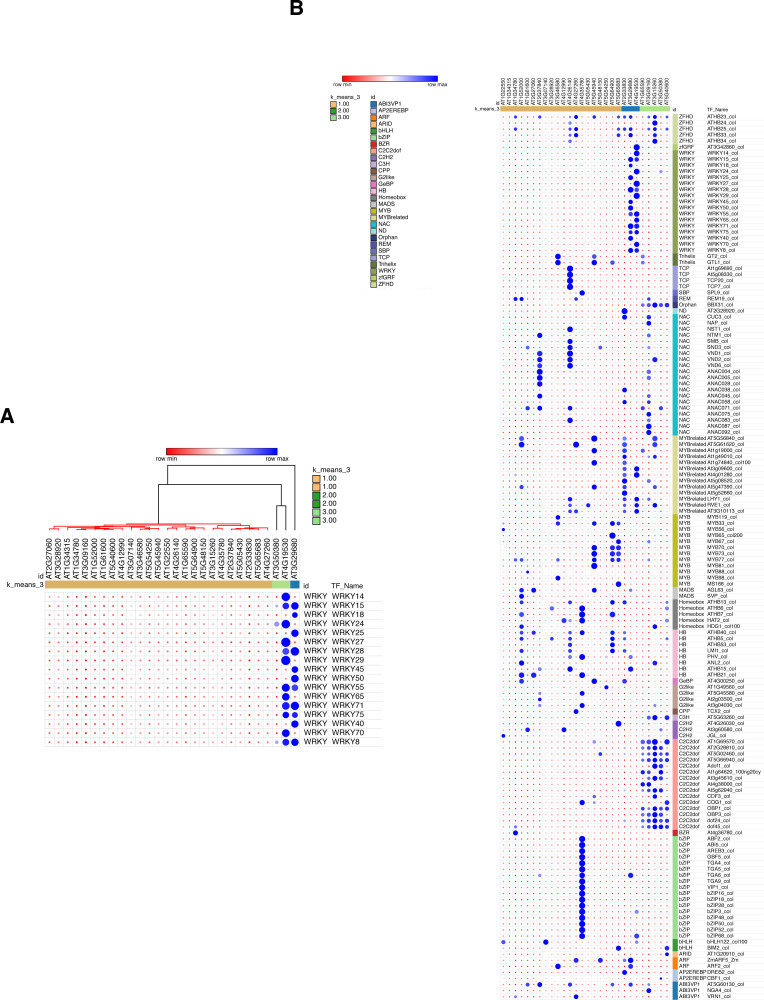
GAT analysis of all the transcription factor classes binding to the 28 stringent less-repressed ROS1 target promoters.(A) GAT analysis performed on publicly available DNA affinity purification sequencing (DAP-seq) data (O'Malley et al., 2016) for WRKY TFs at the 28 stringent less-repressed ROS1 targets, from which promoter hyperDMR sequences exhibiting dense methylated levels in ros1-3 mutants were manually selected. (B) GAT analysis performed on publicly available DAP-seq data (O'Malley et al., 2016) identified TFs with significant enrichment at the promoter demethylated regions from the 28 stringent less-repressed ROS1 targets.